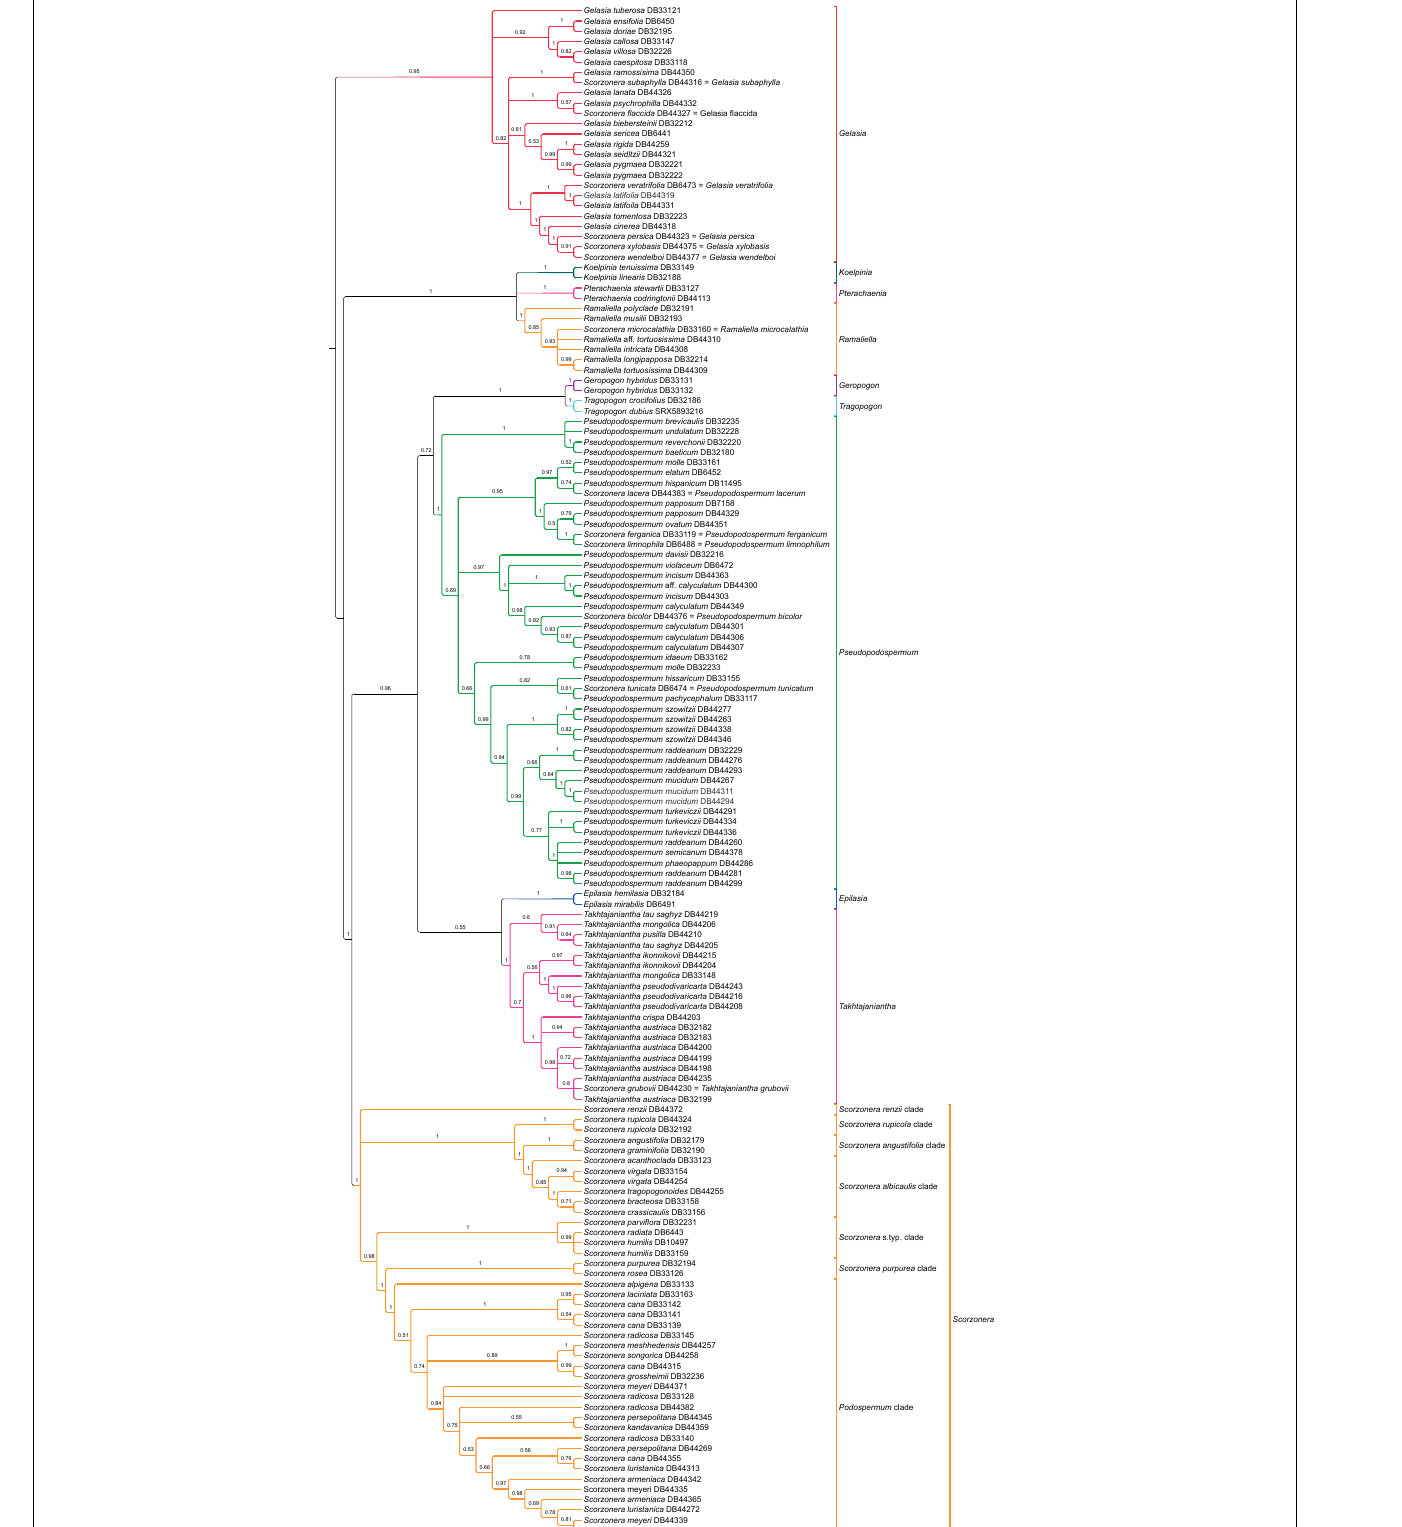
FIGURE 6 | Coalescent species tree of subtribe Scorzonerinae based on the supercontig dataset. Branch labels indicate support values of local posterior probabilities (LPP) and branches with less than 0.5 LPP are collapsed.